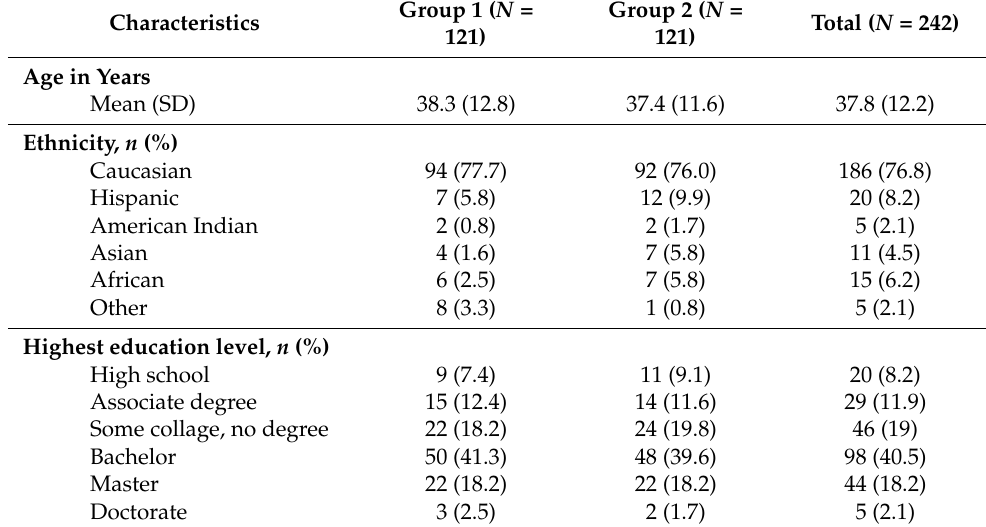
Table 1. Participants’ characteristics.